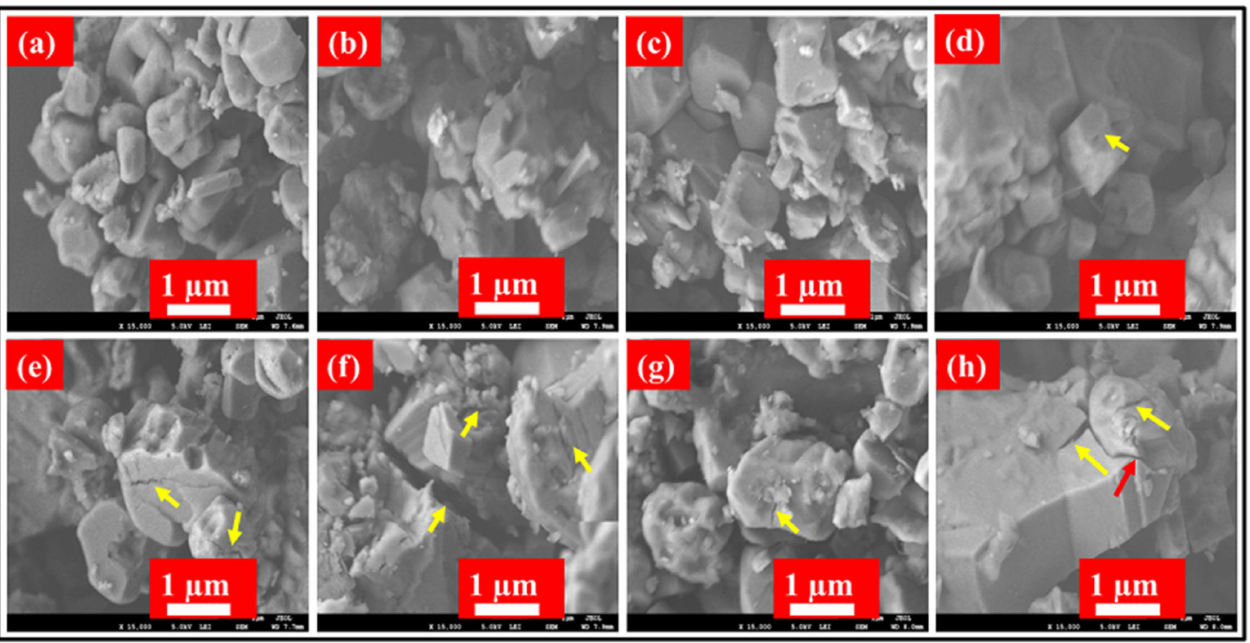
Figure 6. SEM images ( × 15,000, 5 kV) of the untreated and microwave-treated (2.45 GHz, 1.7 kW, 4 min) sample S1: ( a – d ) untreated, ( e – h ) microwave-treated.